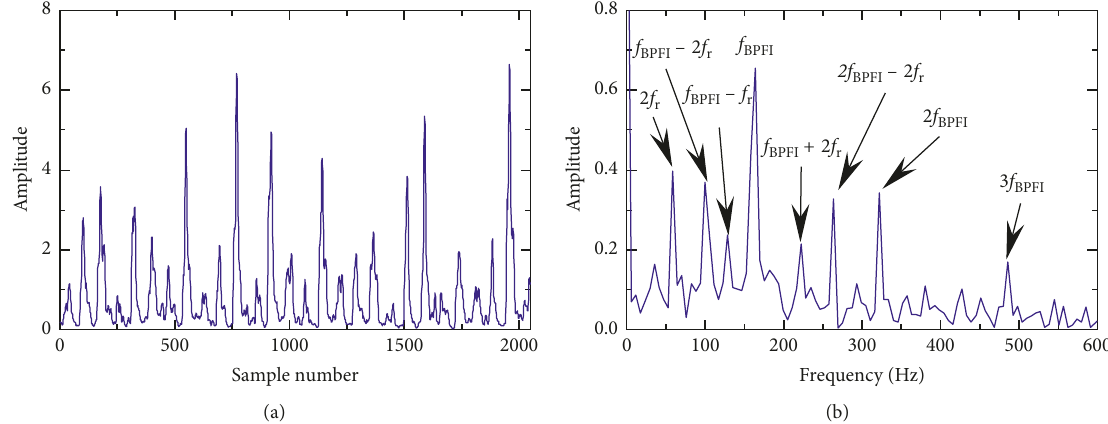
Figure 14: Case 1: waveform and spectrum of the MECGMF filtering result: (a) time-domain waveform; (b) amplitude